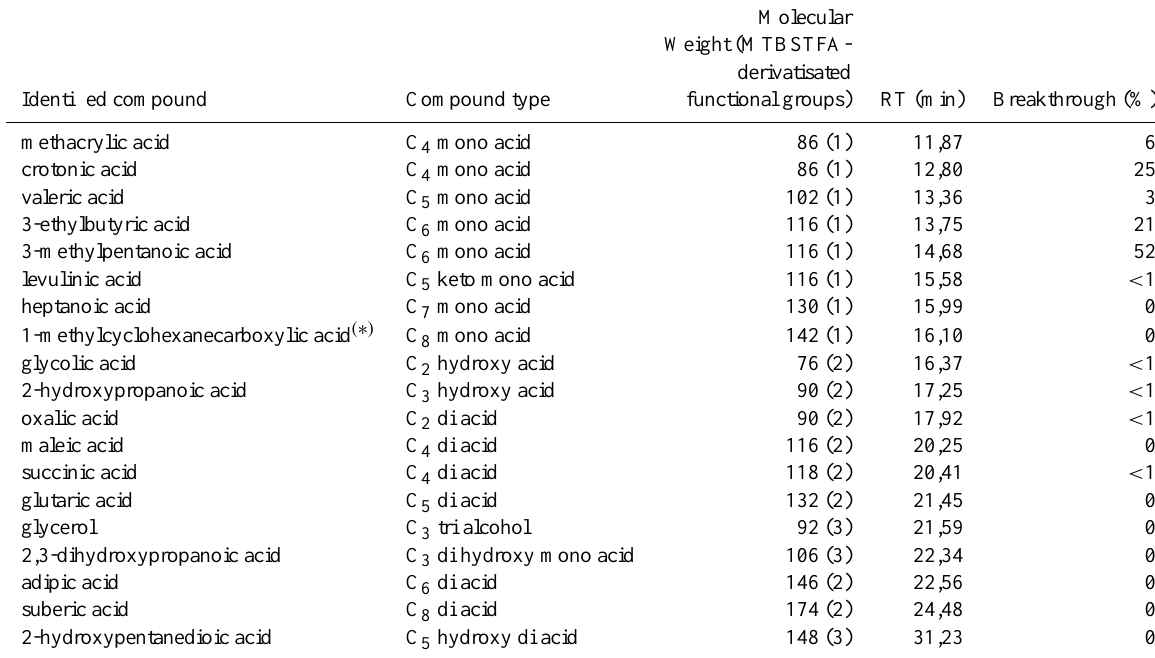
Table 2. Breakthrough data, in percentage corresponding to the back-up tube/sample tube ratio for the quantified compound, for a series of hydroxyl 1 and carboxyl compounds identified from an isoprene photo-oxidation experiment vs. compound type, molar mass, MTBSTFA- derivatised functional groups and retention times